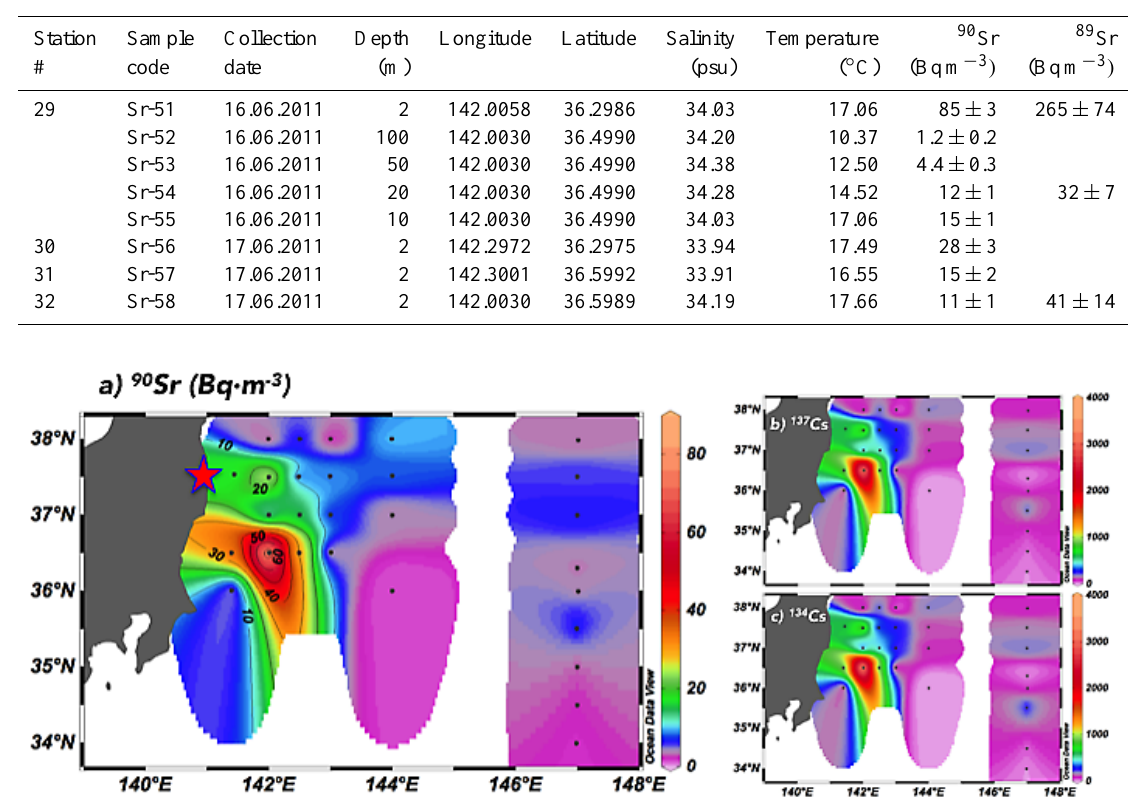
Fig. 2. (a) Activities of 90 Sr in surface seawater samples (expressed in Bqm − 3 ) . Grey contour on the left represents the Japanese coast. The red star stands for the Fukushima NPP. The right-hand plots show the specific activity of 137 Cs (b) and 134 Cs (c) in surface waters from Buesseler et al.